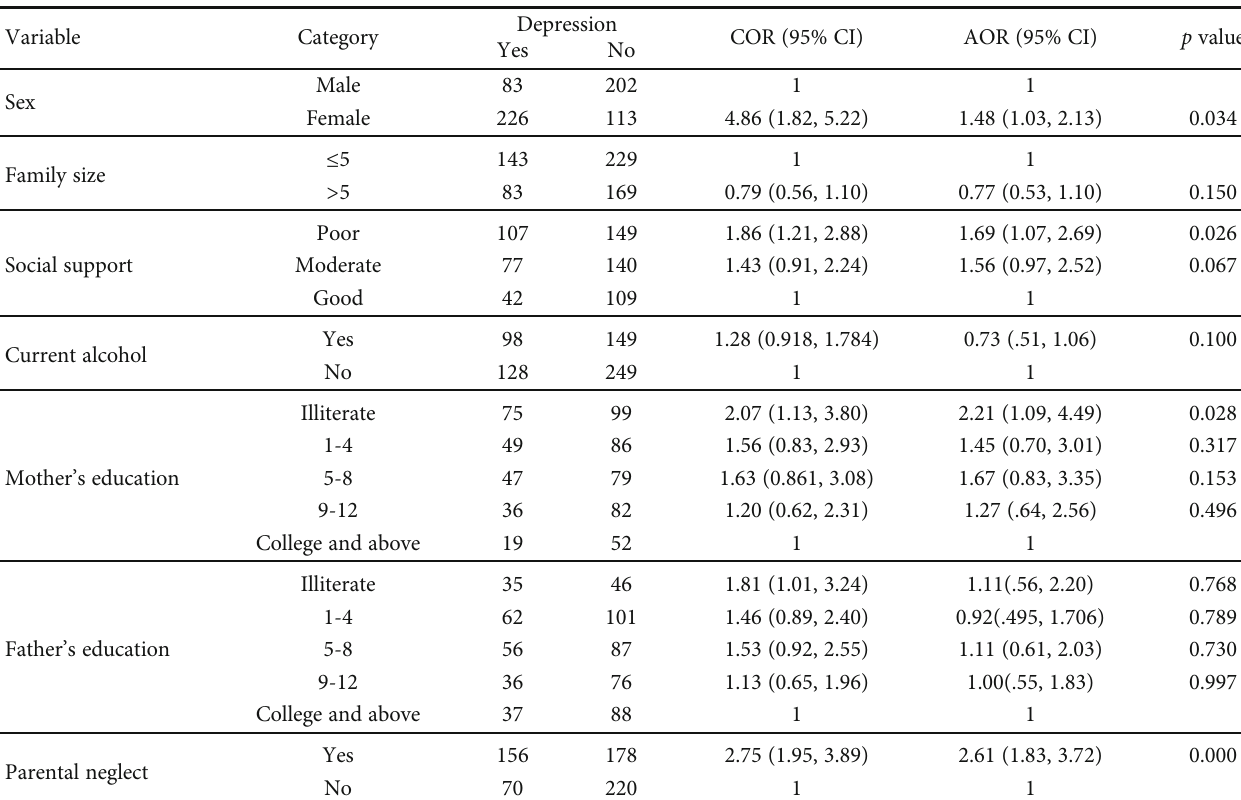
Figure 3: Characterization of depression severity among adolescents in governmental high schools at Aksum town, 2019 ( n = 624 ). Table 3: Bivariate and multivariate logistic analysis of factors associated with depression among adolescents in the sampled governmental high schools in Aksum town, Ethiopia, 2019 ( n = 624